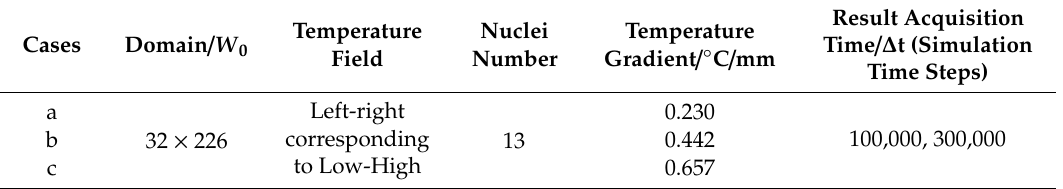
Table 3. Simulation parameters for the microstructure evolution under di ff erent